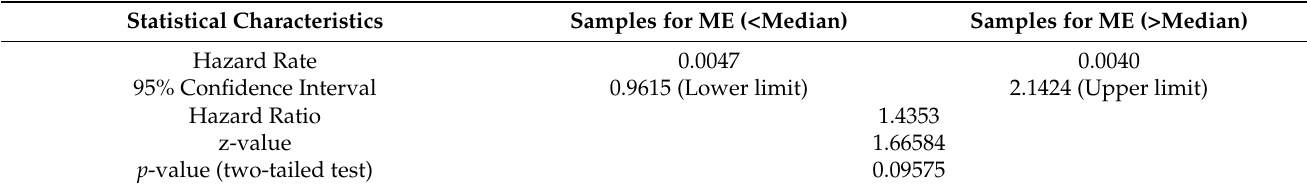
Table 1. Statistical values of log-rank test for the training dataset corresponding to Figure 4A.